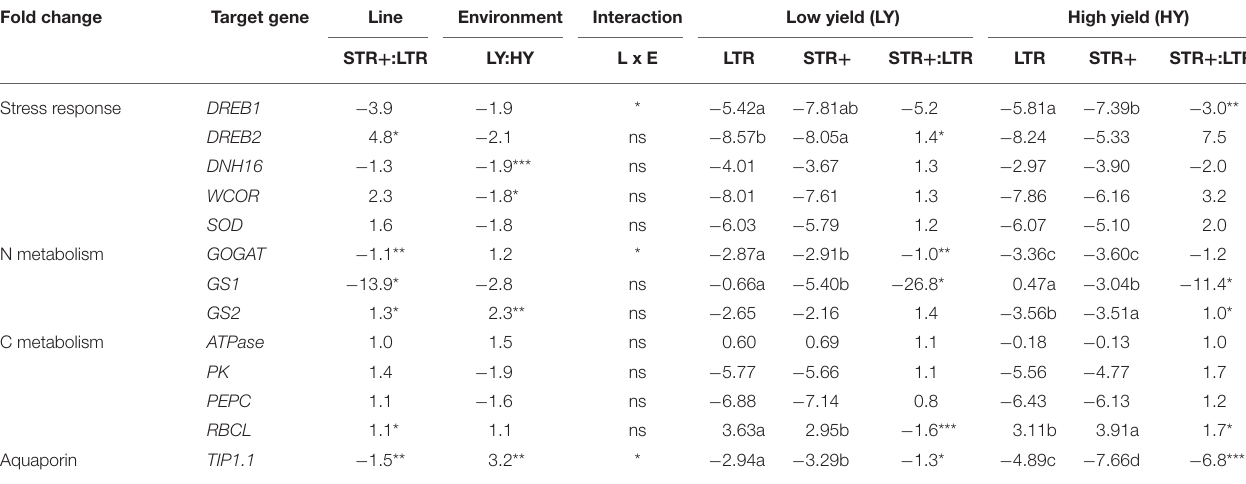
The left columns show the fold change in expression of the STR + lines relative to the LTR lines (Lines column), of LY with respect to HY (Environment column) and their interaction (L x E). Each yield environment (HY and LY) includes data of two trials (i.e., growing conditions) at different locations. For each line and trial assayed three biological (i.e., plot) replications were considered. The Low Yield (LY) and High Yield (HY) columns show the fold change relative to reference genes of the LTR and STR + groups under HY and LY conditions, as well as the fold change of the STR + relative to the LTR lines in each environment. The comparisons were assessed by ANOVA and the LSD test using a log 2 transformation of the fold change values. Different letters indicate significant differences (p < 0.05), while asterisks indicate levels of significance (ns, non-significant; * p < 0.05; ** p < 0.01; *** p < 0.001). Positive values indicate up-regulation and negative values indicate down-regulation of target genes. For details see section Materials and